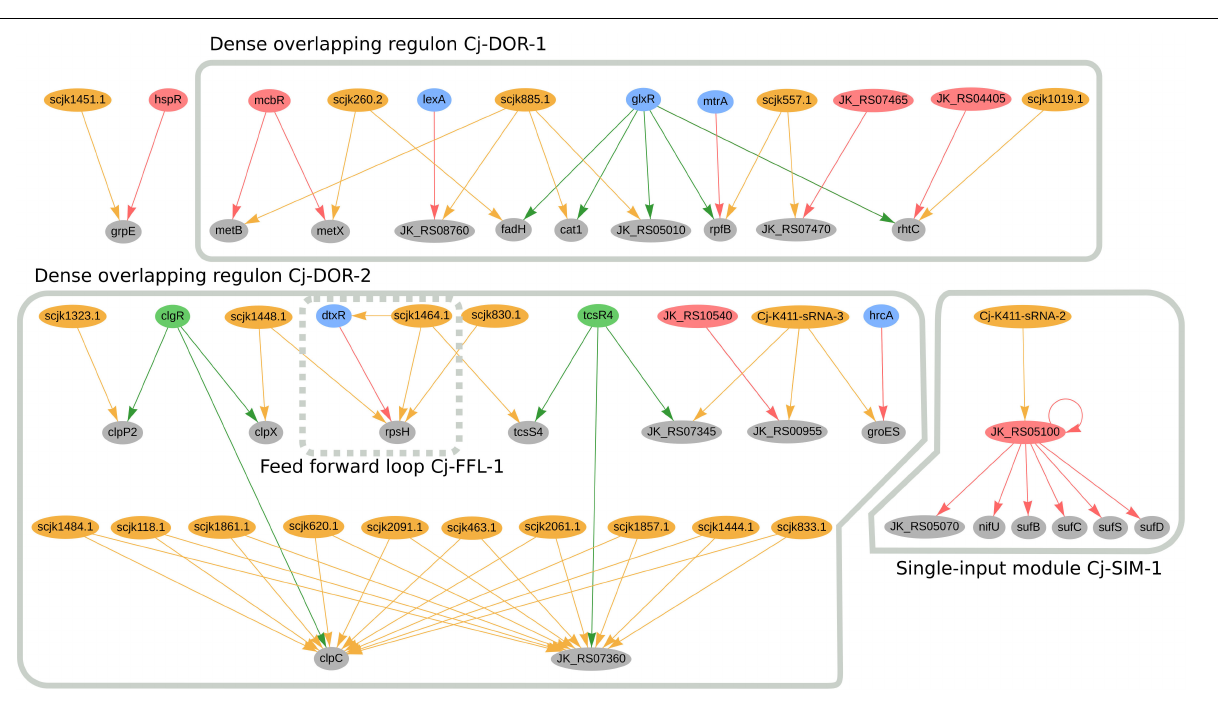
Frontiers in Microbiology |